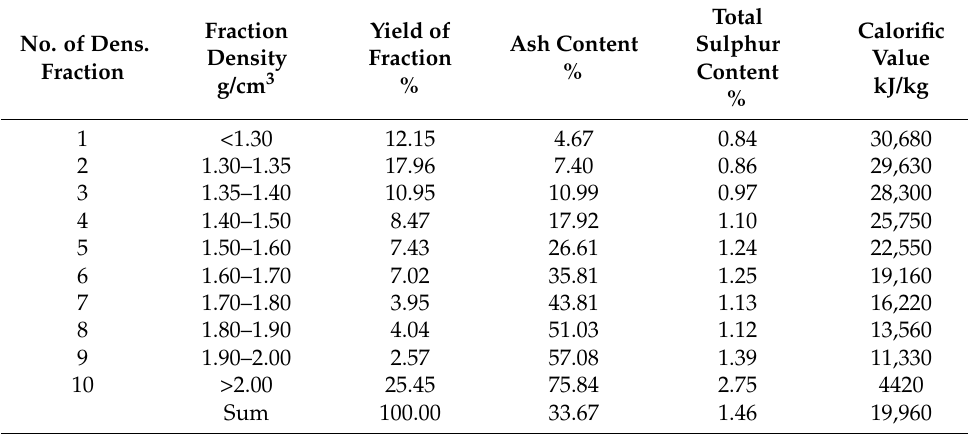
Table 1. Density-quality characteristics of the raw feed stream (8–20